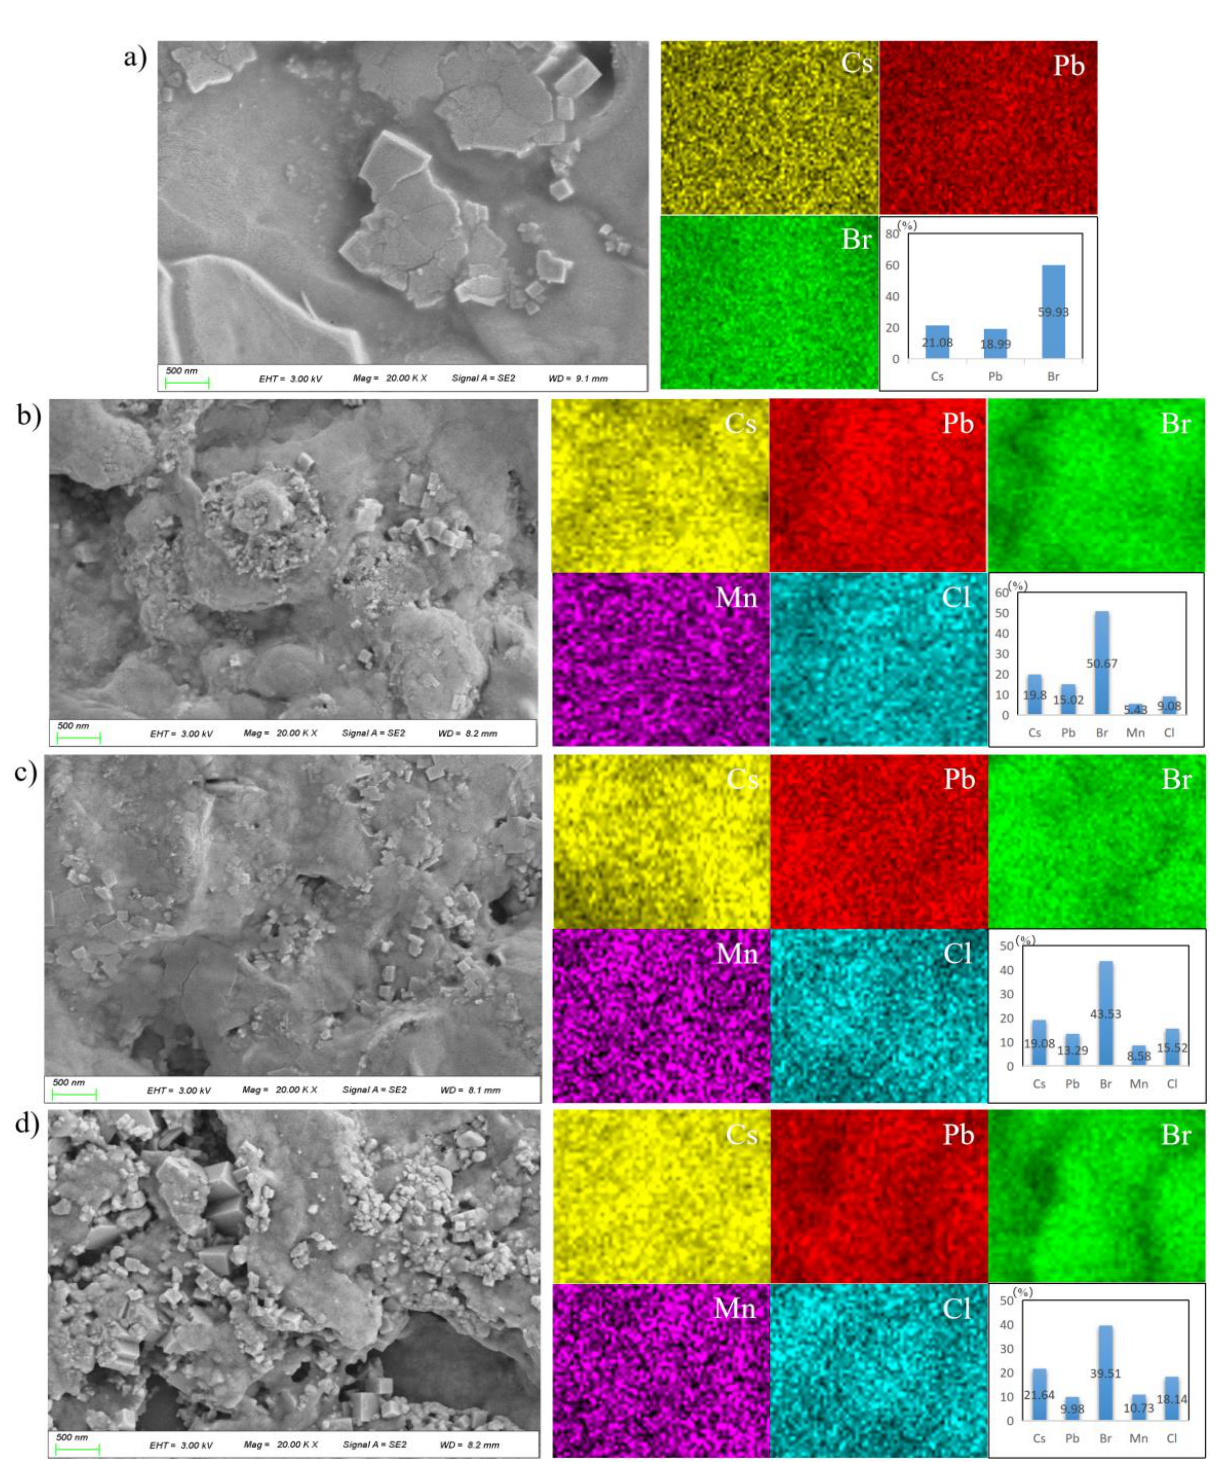
Figure 3. Morphologies and EDS mappings of the samples prepared by different PbBr 2 /MnCl 2 ratios: ( a ) 3:0; ( b ) 3:1; ( c ) 3:2; ( d ) 1:1.